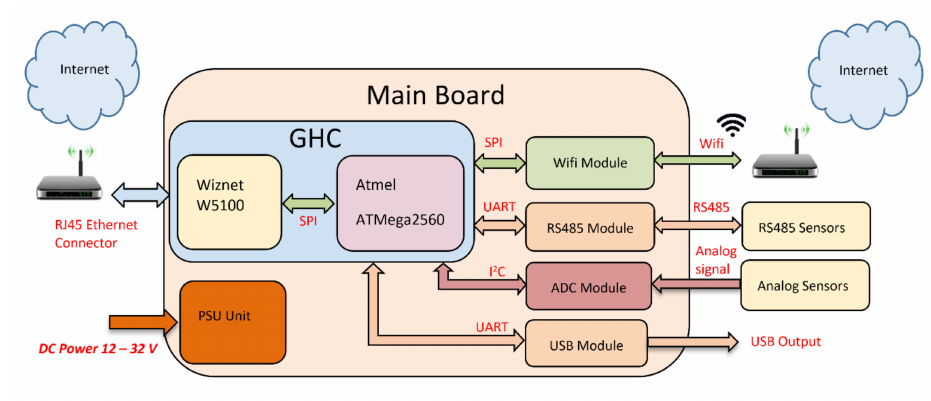
Figure 1. Block diagram of the electronic board.